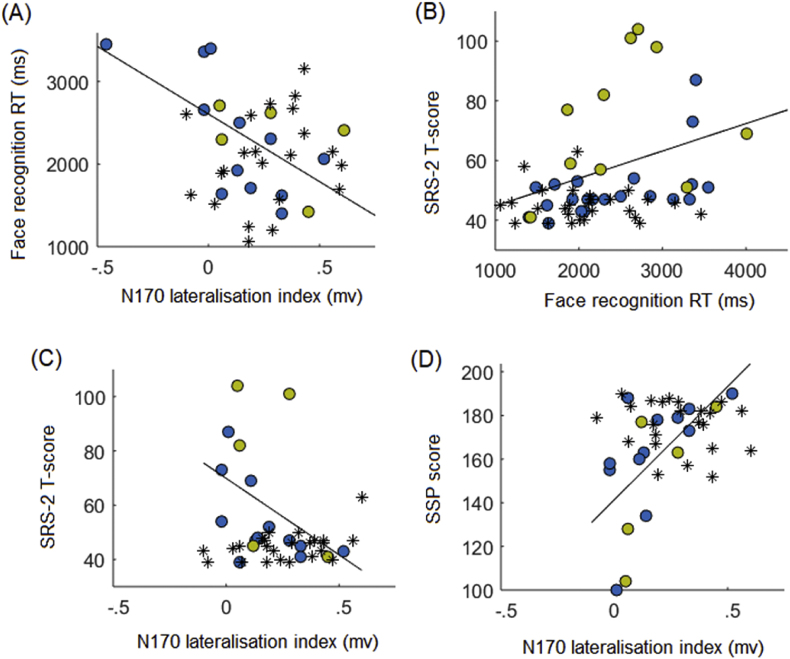
Cross-sectional associations between face recognition performance, face processing ERP indices and ASD symptoms in mid-childhood. Scatterplots show the associations between face recognition performance, ERP indices of face processing and ASD symptoms in mid-childhood in the HR group. The blue circles indicate data from the HR children without ASD and yellow circles indicate HR children with ASD; the regression lines represent the association between the variables in the HR group (HR-ASD and HR-non-ASD children combined). Black asterisks represent data points from the LR group and are shown only for visual comparison with the HR group associations. Panel (A) shows the negative association between RT for correctly recognising faces in the face recognition task and the extent to which the N170 ERP component for faces was lateralised to the right hemisphere; faster RTs were associated with greater right-lateralisation of the N170. Panel (B) shows the positive association between RTs for correctly recognising face stimuli in the face recognition task and SRS-2 scores; faster RTs were associated with fewer social-communication problems. Panel (C) shows the negative association between lateralisation of the N170 ERP component and SRS-2 scores; greater right-lateralisation of the N170 was associated with fewer social-communication problems. Panel (D) shows the positive association between lateralisation of the N170 ERP component and SSP scores; greater right-lateralisation of the N170 was associated with fewer sensory symptoms (higher SSP scores).